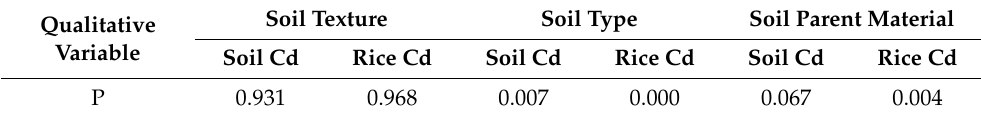
Table 2. ANOVA analysis for testing the significance and effects of three qualitative variables on the variance of cadmium in rice.